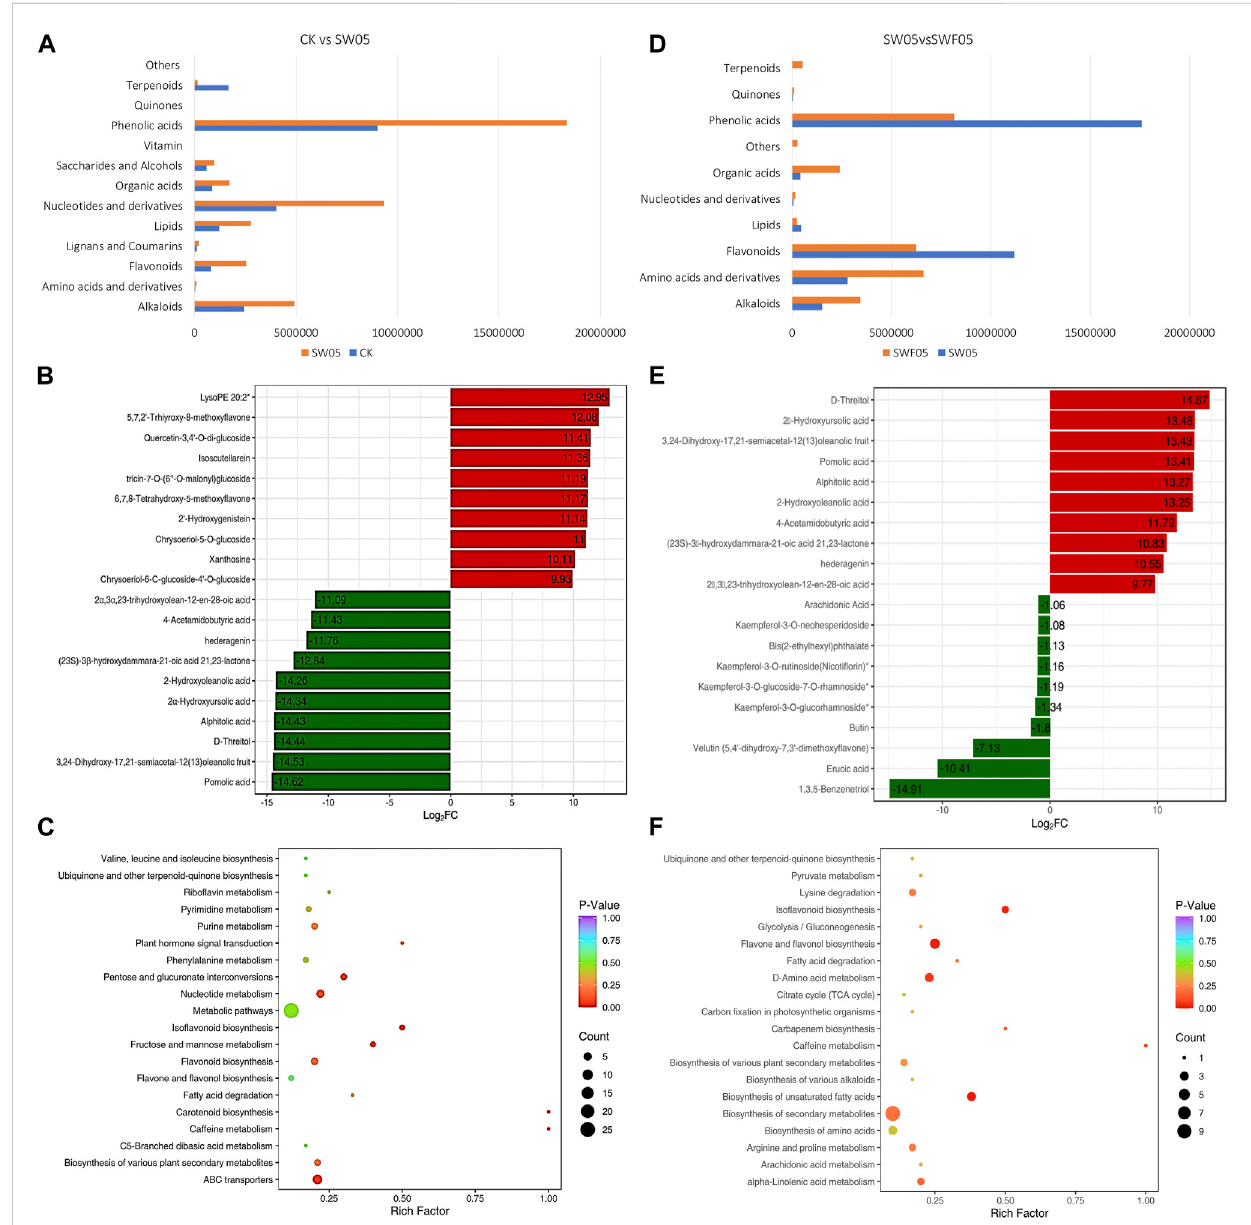
FIGURE 3 Drought stress and rewatering driven metabolomic changes in Adiantum leaves. (A) Changes in the accumulation pattern of major compound classes after 5 days of drought stress. The bars represent the sum of the relative intensities of compounds included in each class. (B) top and bottom 10 accumulated compounds in Adiantum leaves after 5 days of drought stress, and (C) scatter plot showing the pathways to which the DAMs were signi fi cantly enriched 5 days after drought stress. (D) Changes in the accumulation pattern of major compound classes on day fi ve after rewatering. The bars represent the sum of the relative intensities of compounds included in each class. (E) top and bottom 10 accumulated compounds in Adiantum leaves on day fi ve after rewatering, and (F) scatter plot showing the pathways to which the DAMs were signi fi cantly enriched on day fi ve after